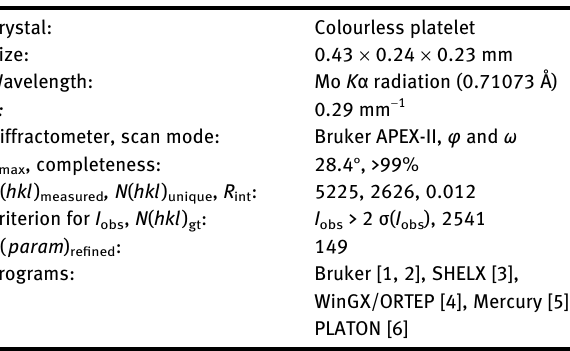
Table  : Data collection and handling.